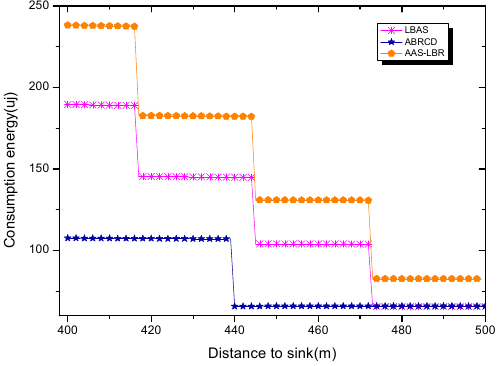
Figure 27. Energy consumption of nodes 400–500 m away from sink under 𝑇 = 20 and r = 28 m .